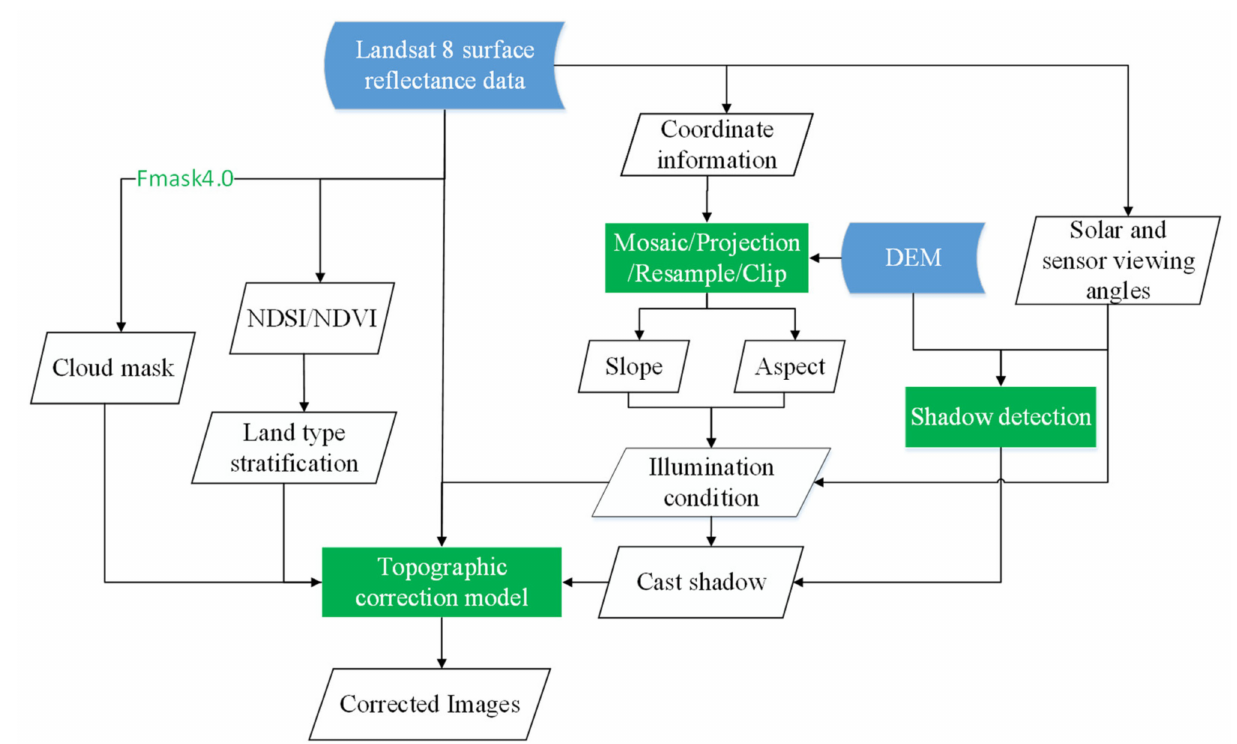
Figure 2. Flow chart of data processing for Landsat topographic